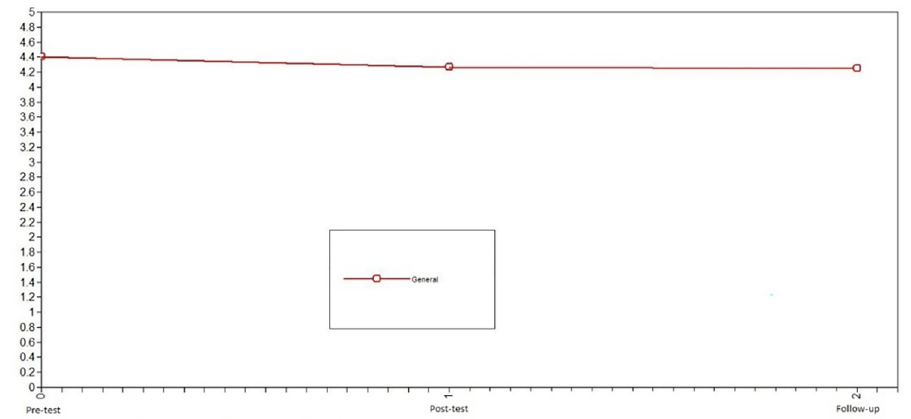
https://doi.org/10.1371/journal.pone.0272922.g007